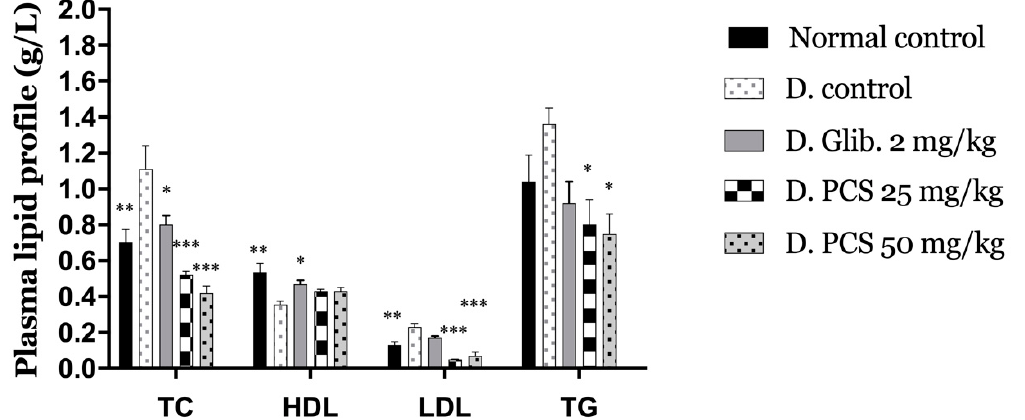
Figure 4. Effect of PCS on Plasma lipid profile in Alloxan-induced diabetic mice after 28 days of experiments. Values are expressed as mean ±SD ( n = 5 mice). * p < 0.05, ** p < 0.01, *** p < 0.001, compared to diabetic control.